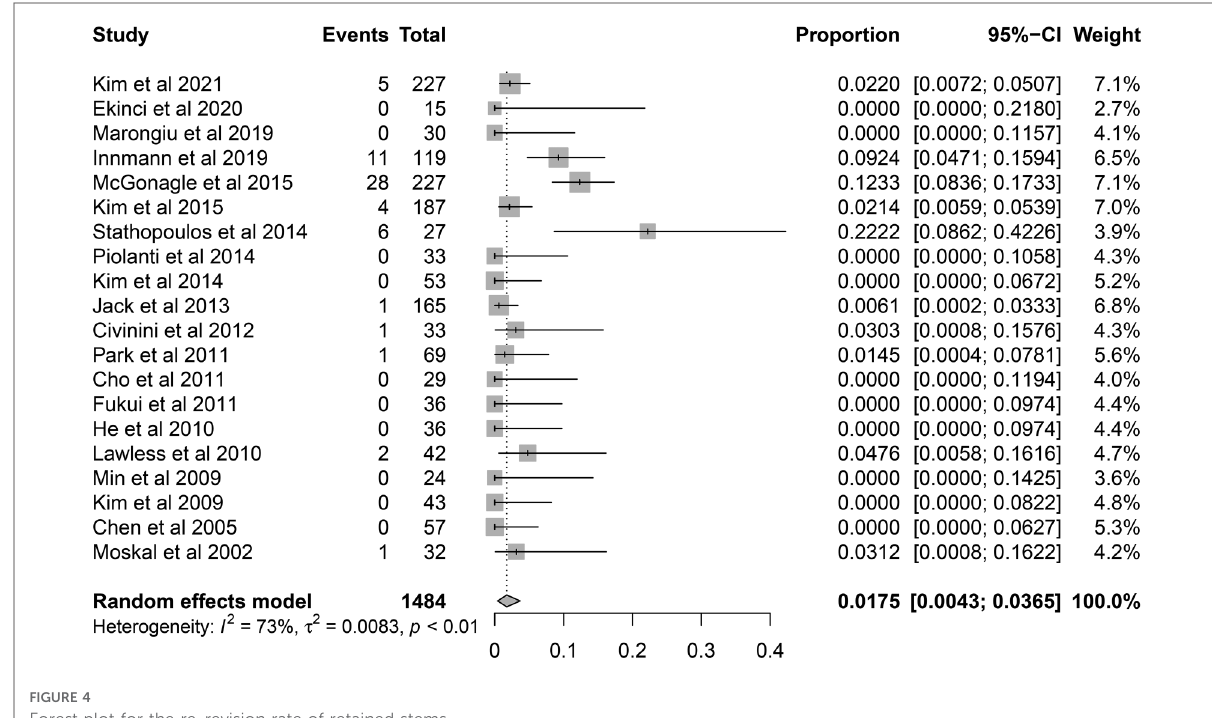
FIGURE 4 Forest plot for the re-revision rate of retained stems.